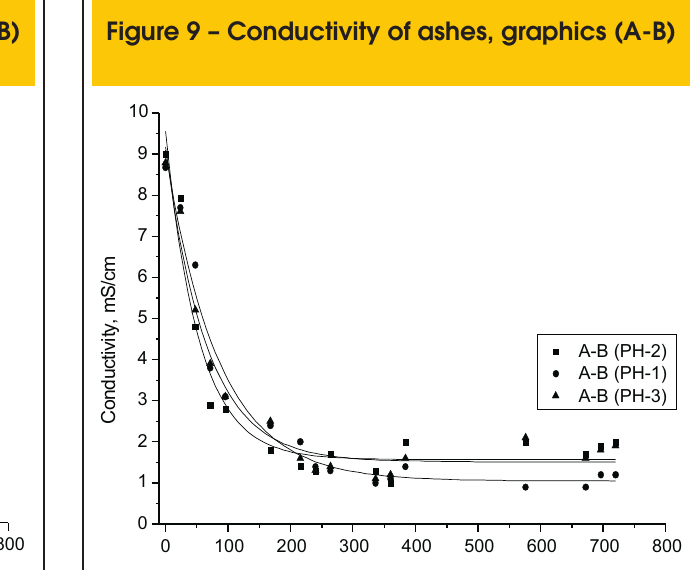
Figure 7 – Conductivity of ashes, graphics (A-B)